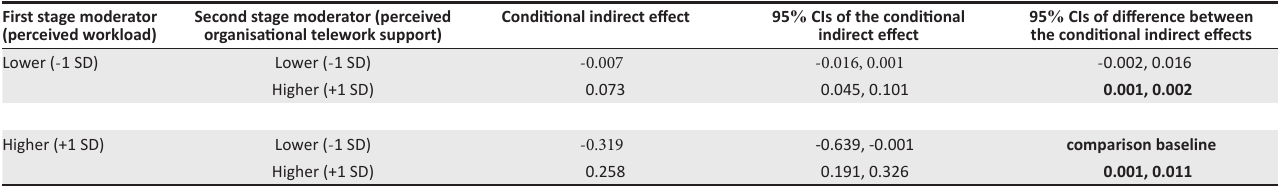
TABLE 2: Conditional indirect effects at different levels of perceived workload and organisational telework support. First stage moderator (perceived workload)